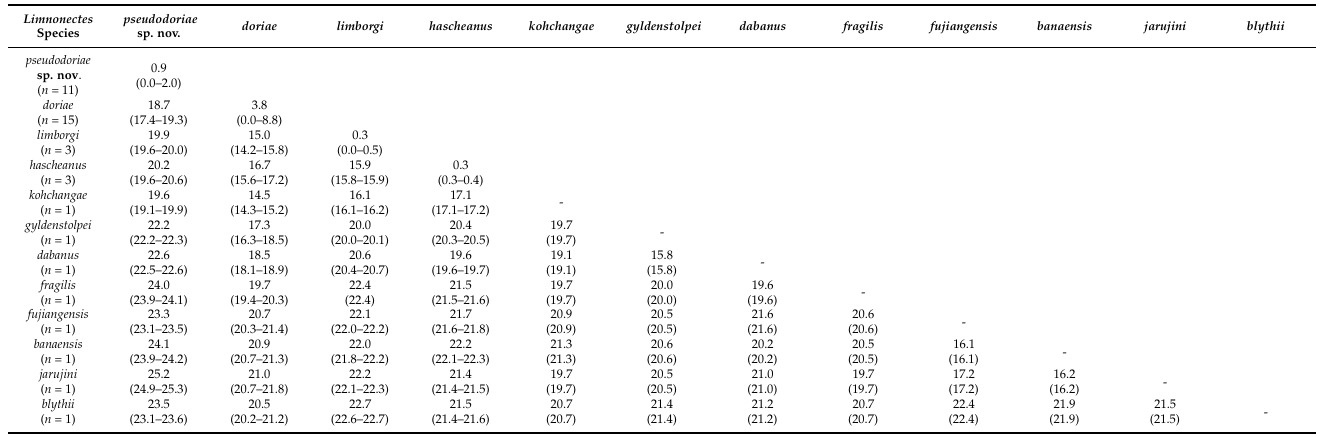
Table 2. Percentage uncorrected pairwise sequence divergences ( p -distances) in the mitochondrial ND3 gene of Limnonectes pseudodoriae sp. nov . and related species. Limnonectes pseudodoriae Species sp. nov. pseudodoriae sp. nov . ( n